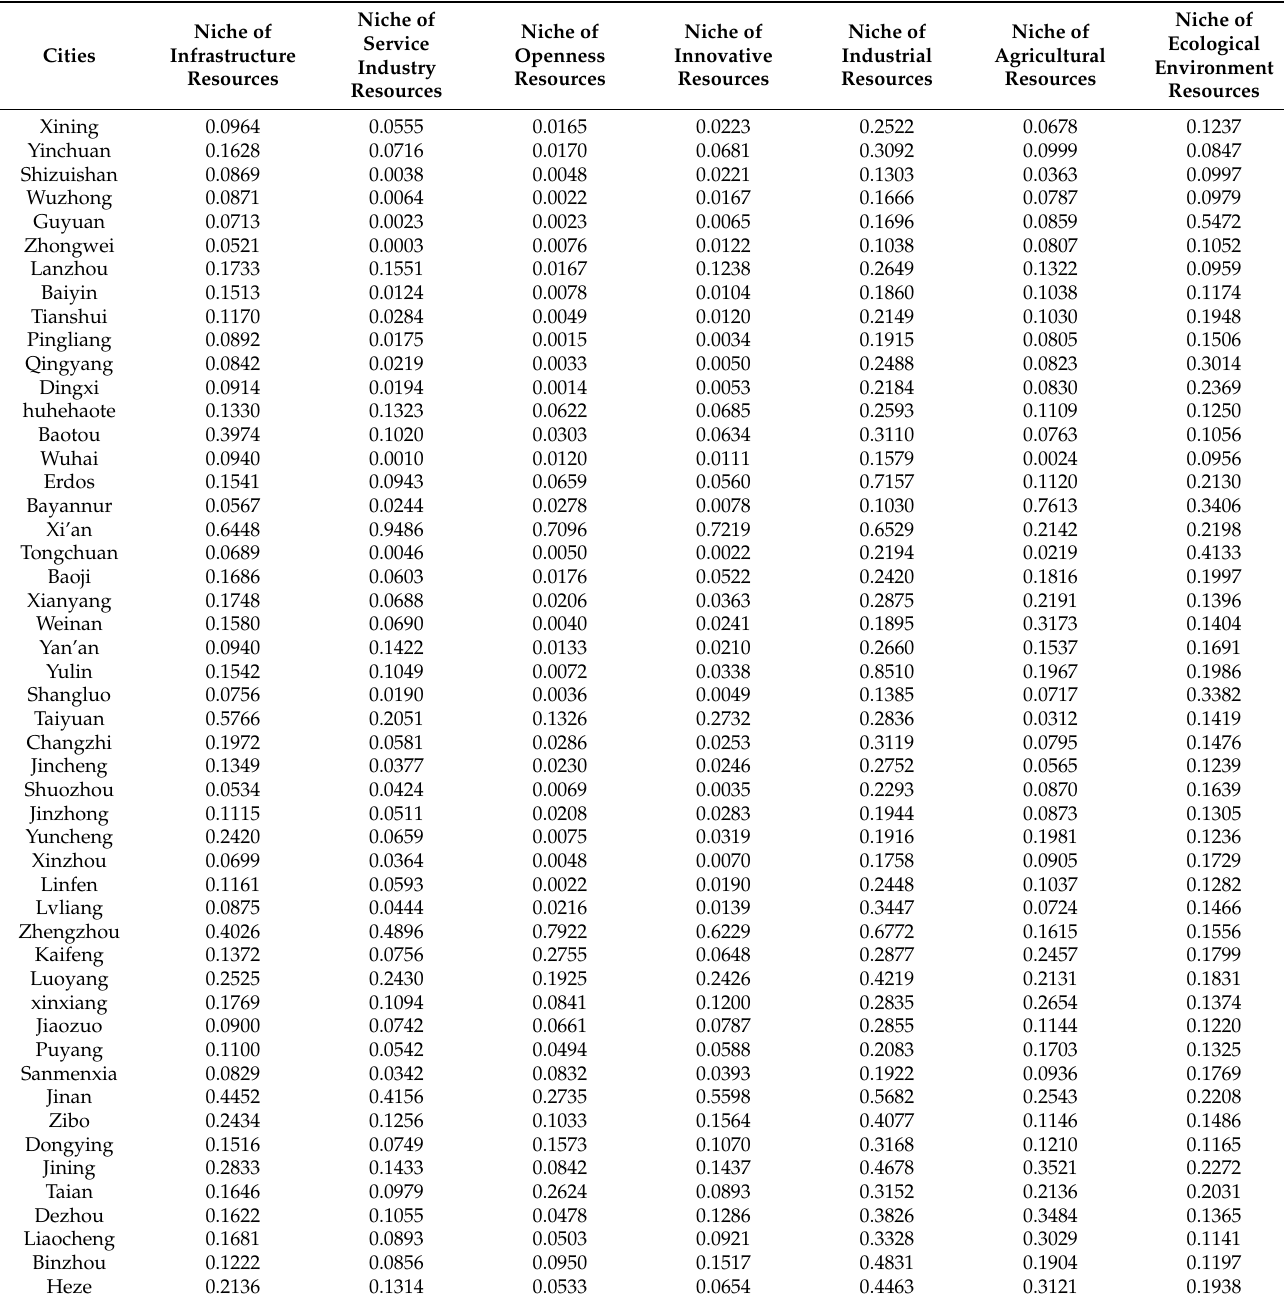
Table 2. Evaluation values of sub-dimensional niche suitability of the high-quality development of YRB cities in